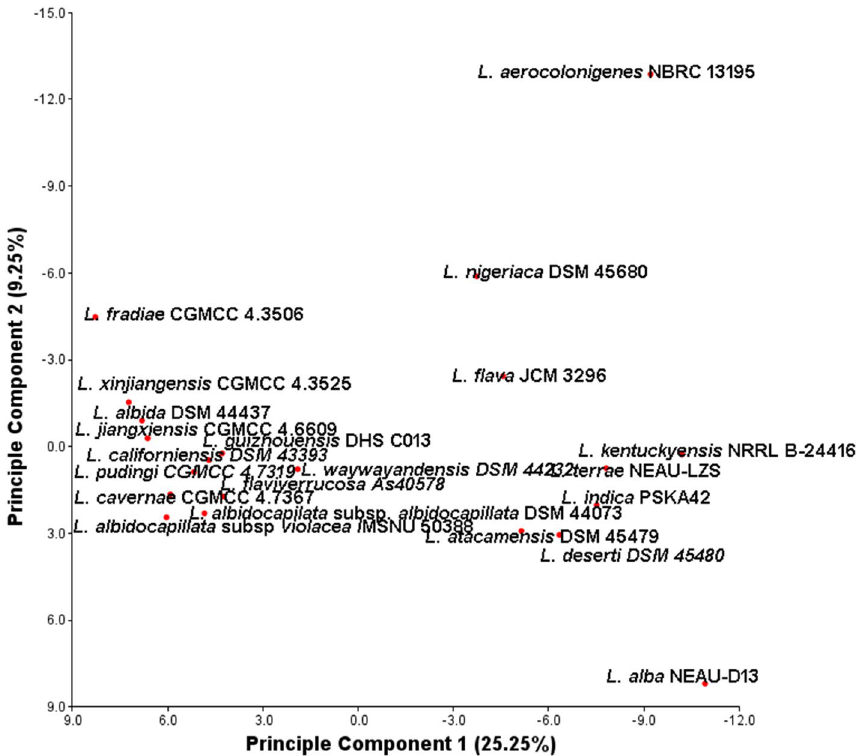
Figure 13. Principal component analysis (PCA) among the different Lentzea based on CAZY enzymes recovered from dbCN2 for their